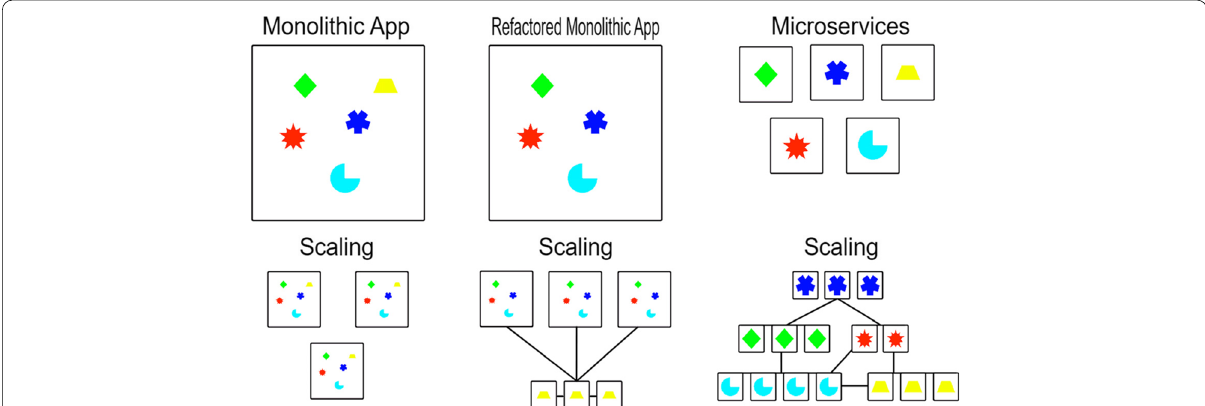
Fig. 2 Difference in scaling between monolithic, refactored, and microservice software architectures (migrating from monolithic applications to